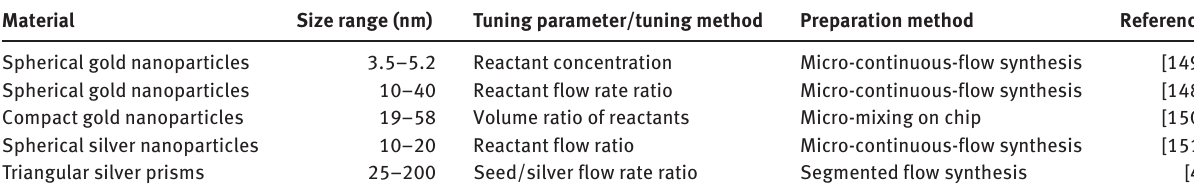
Table 4 Size tuning of plasmonic nanoparticles in microfluidic preparations.